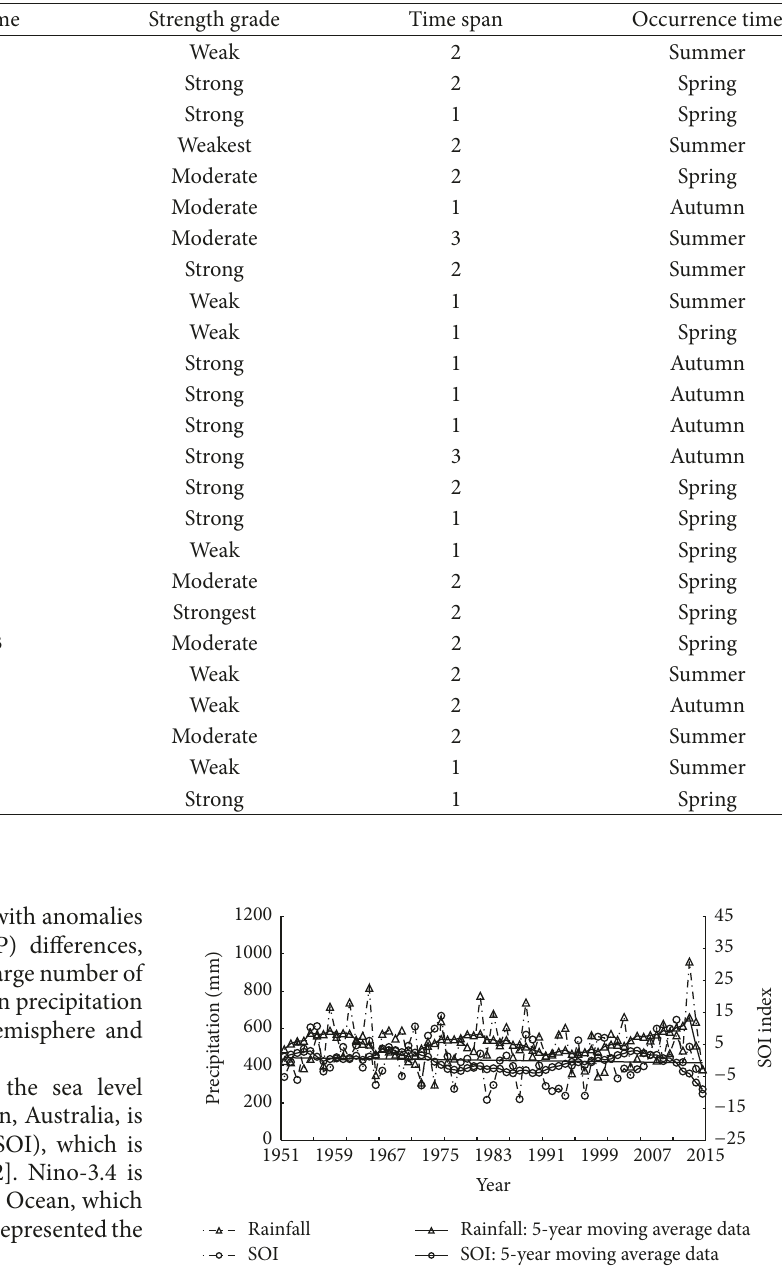
Table 2: El Nino events from 1951 to 2015.